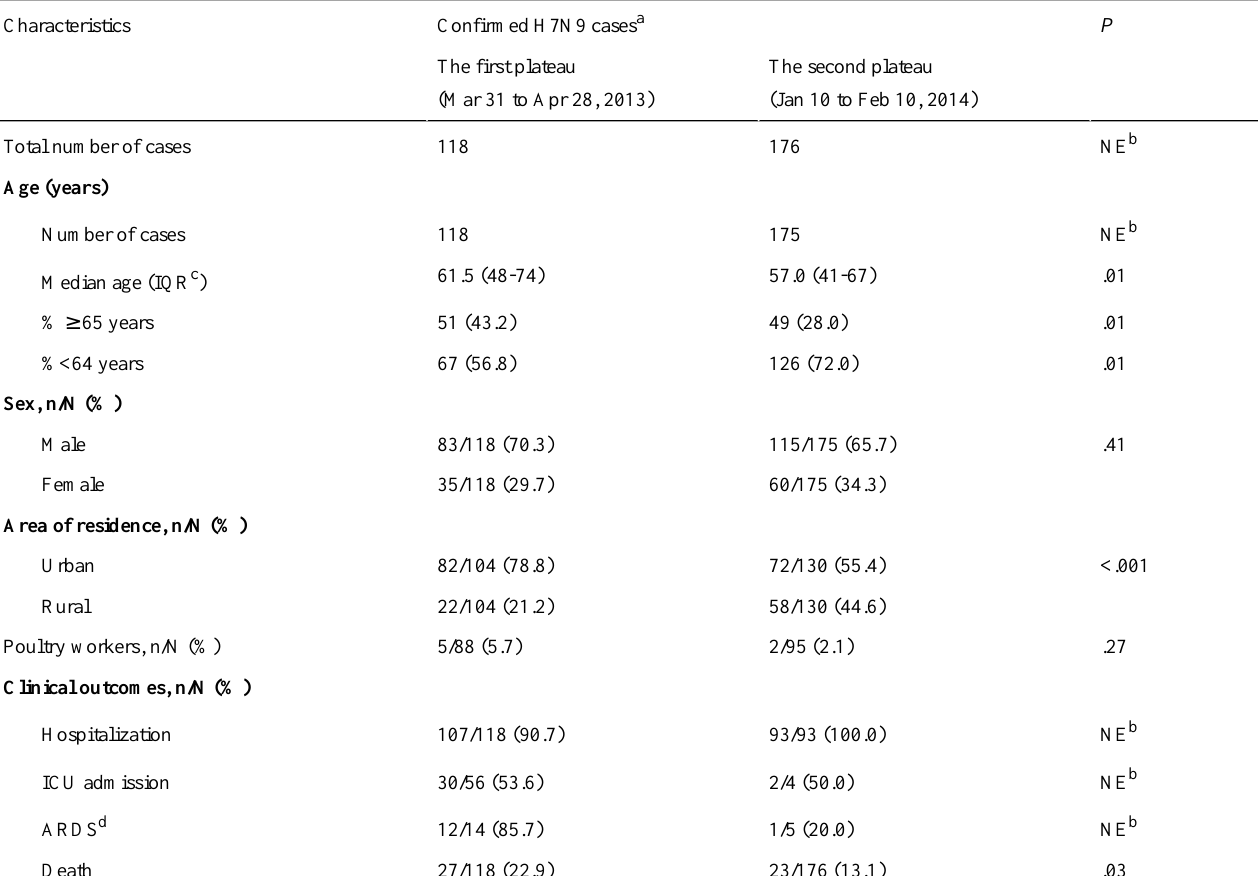
Table 3. Comparison of the characteristics of patients with confirmed H7N9 infection in China between different plateau